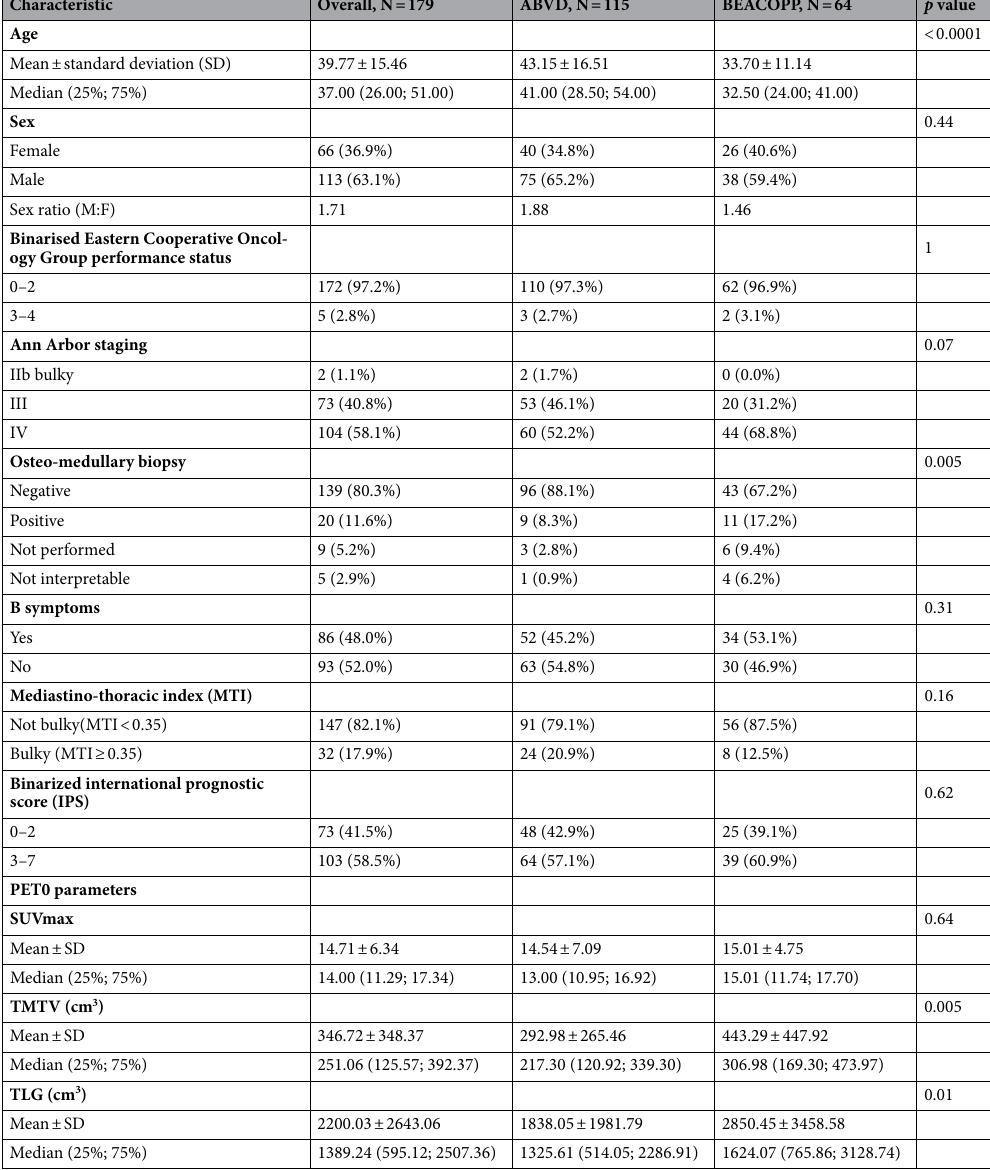
Table 1. Baseline patient